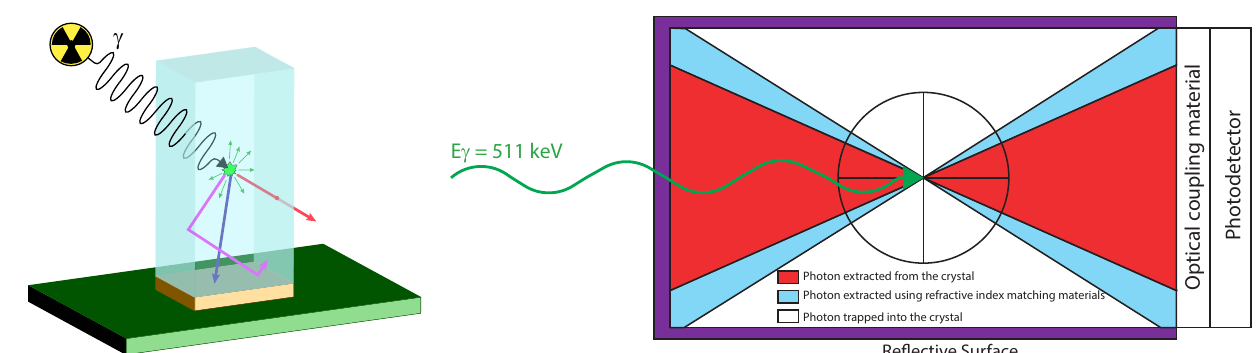
Figure 2. Simplified ionizing radiation detection scheme. ( Left ) The scintillator, attached to a photodetector, is irradiated with gamma rays. The interaction between the ionizing particles and the crystal structure generates optical photons isotropically. The latter can reach directly the output surface and be extracted from the crystal ( blue arrow). Some photons will however be refracted at the other crystal surfaces and eventually escape from the crystal ( red arrow ). Other photons will undergo total internal reflection and be trapped within the crystal ( purple arrow ). ( Right ) Only a limited portion of photons is going to be extracted when employing specular reflective surfaces ( violet structures ). The situation improves by optimizing the optical coupling.